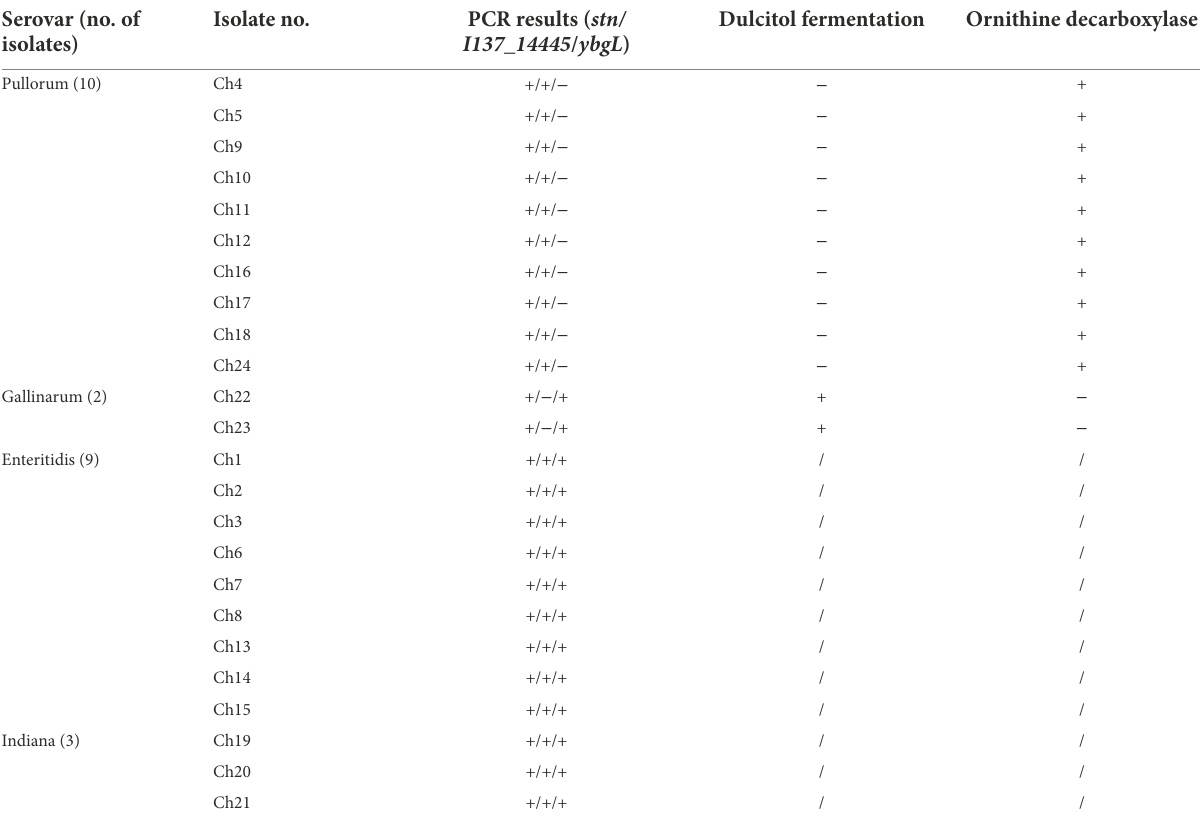
TABLE 2 The developed multiplex PCR method was applied for the identification of Salmonella isolates from one chicken farm. Serovar (no. of Isolate isolates)